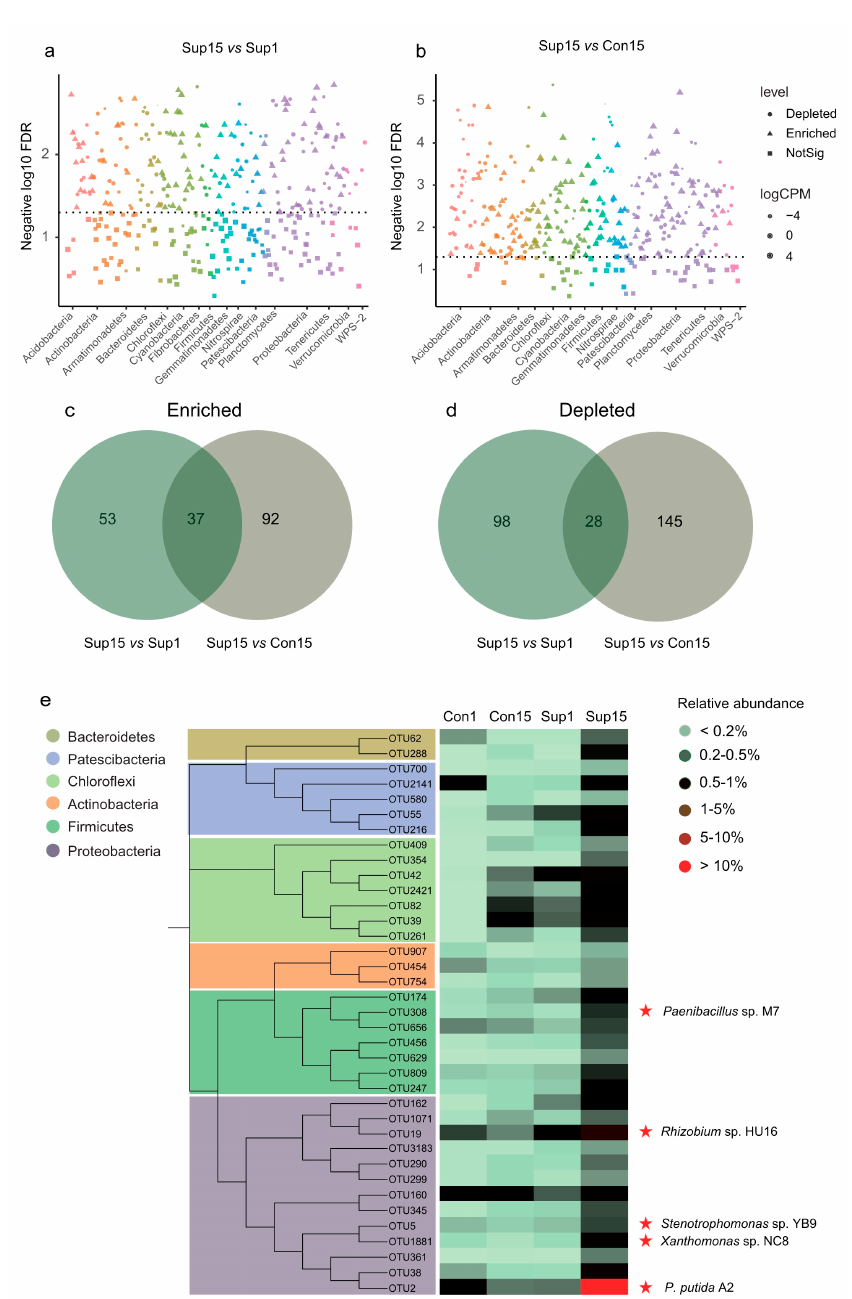
Figure 5. Analyses of differentially enriched or depleted OTUs in the 15-year suppressive soil (Sup15), compared with the 1-year suppressive soil (Sup1) or 15-year conducive soil (Con15), with an average abundance ≥ 0.1% and logFC ≥ 1.0. Manhattan plots showing differential OTUs in the Sup15 compared with Sup1 ( a ) and Con15 ( b ), respectively. Venn diagram showing the number of shared and unique OTUs in the enriched ( c ) and depleted ( d ) OTUs. Neighbor-joining analysis of the shared OTUs (left) among these enriched OTUs with relative abundance (right) in different soil samples, and stars (right) indicated five isolated strains corresponding to the shared OTUs that were highly abundant in the Sup15 ( e ).